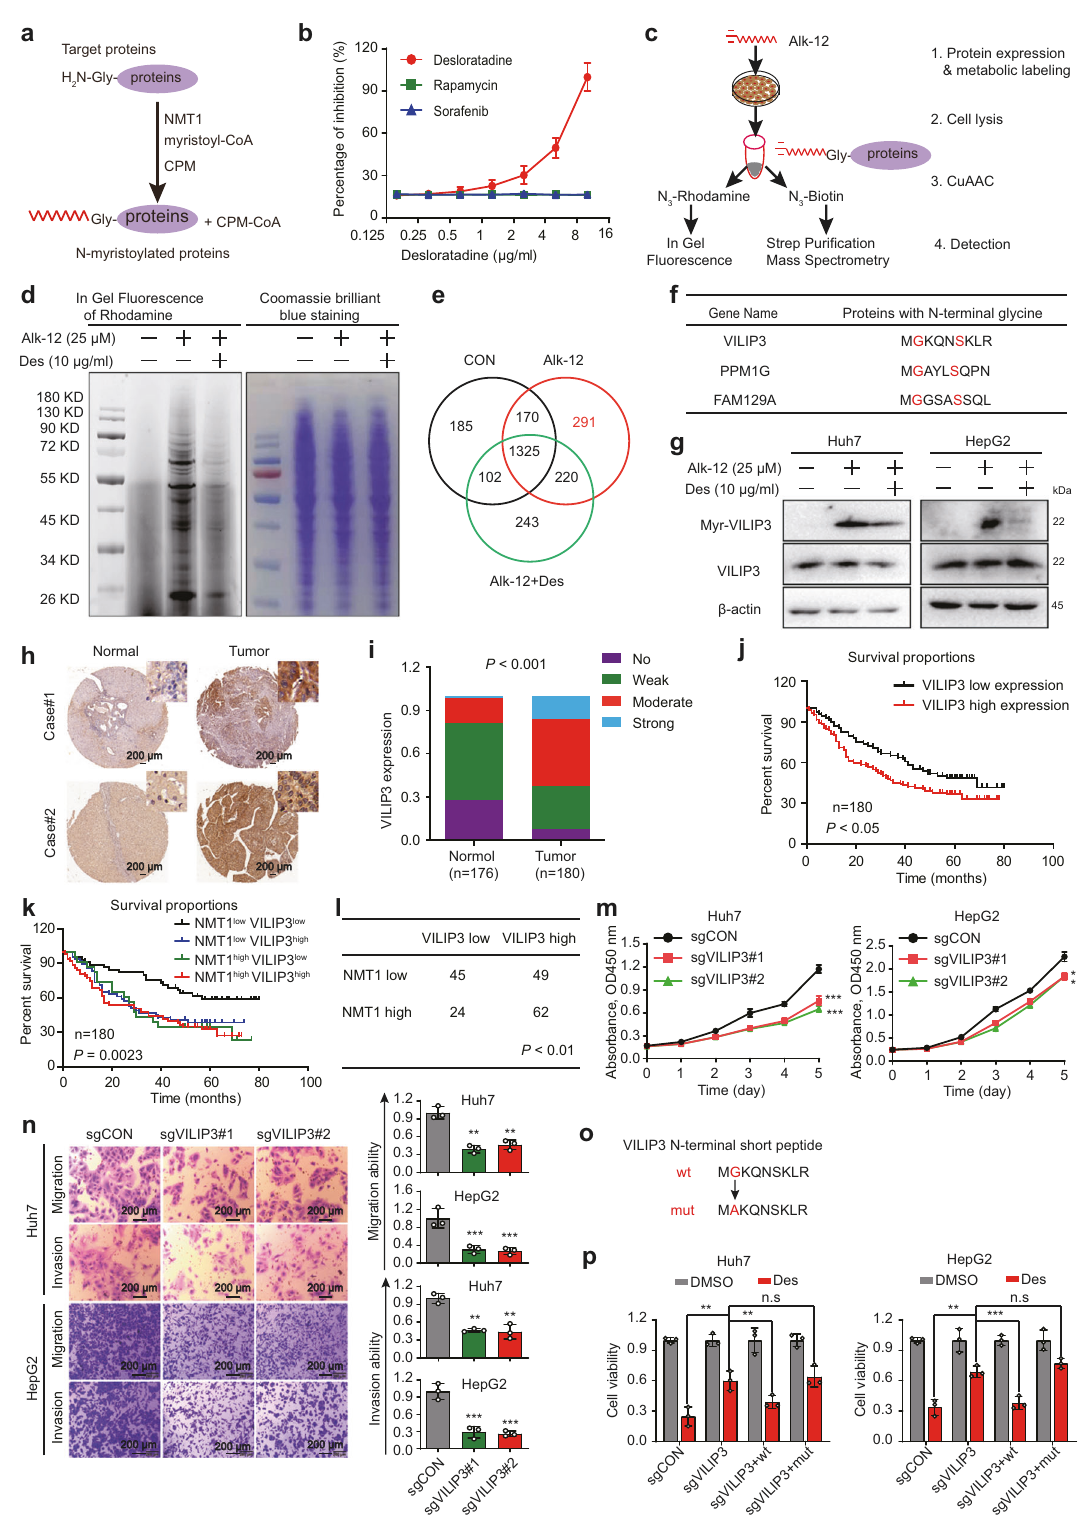
modern H 1 antihistamines have not been widely studied in this role. 39 A third-generation antihistamine, desloratadine, was reported to cause fewer adverse drug reactions in the central nervous system than fi rst- and second-generation antihista- mines. 40 In this study, the direct binding between the